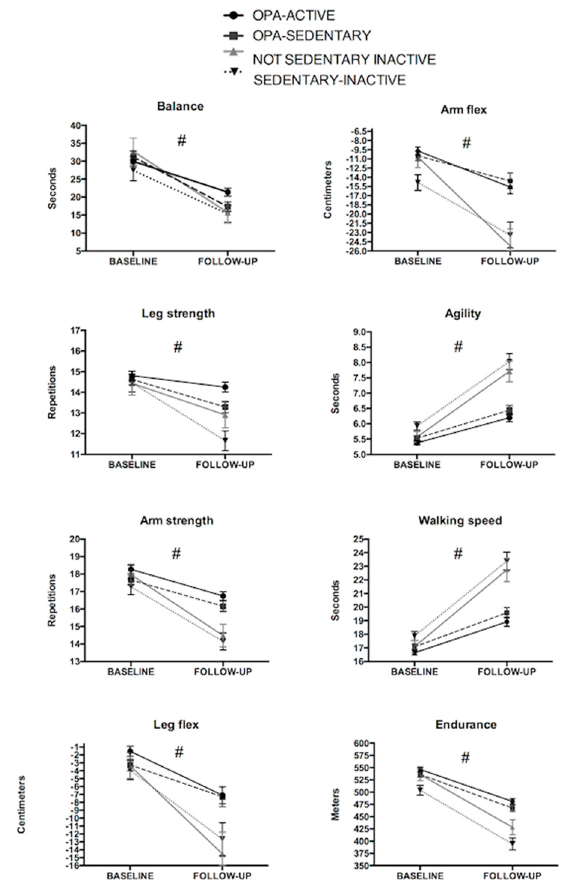
Figure 5. Fitness changes according to OPA engagement and sedentary behaviors. # Significant group-by-time interaction among the 4 groups. All groups showed a significant decrease from baseline to follow-up ( p < 0.05).